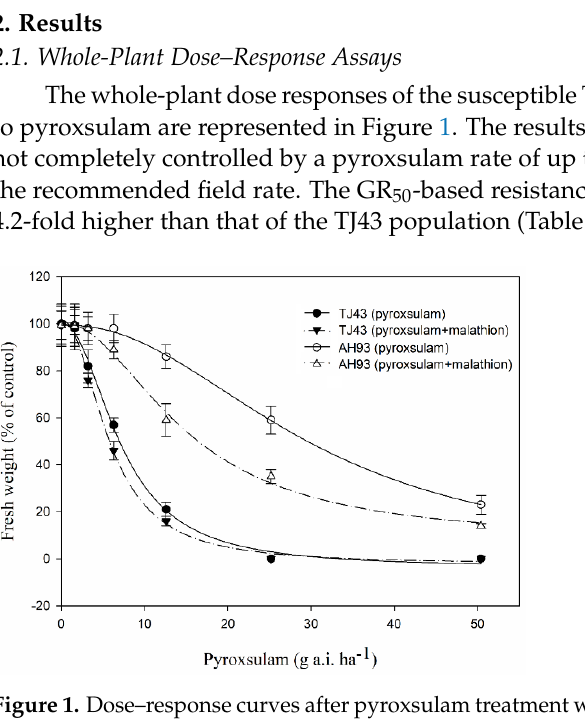
Table 1. GR 50 values of pyroxsulam for the susceptible TJ43 and resistant AH93 A. myosuroides pop- ulations.